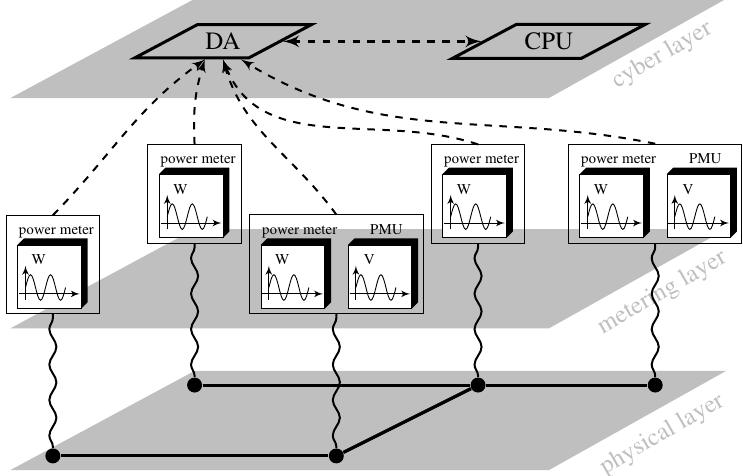
Figure 1. Smart grid envisioned as a cyber-physical system consisting of three layers. From top to bottom, (i) cybernetic layer, in charge of data aggregation and computational burden, (ii) metering layer, in charge of measurement collection, and (iii) physical layer, consisting of the actual electrical buses and branches of the